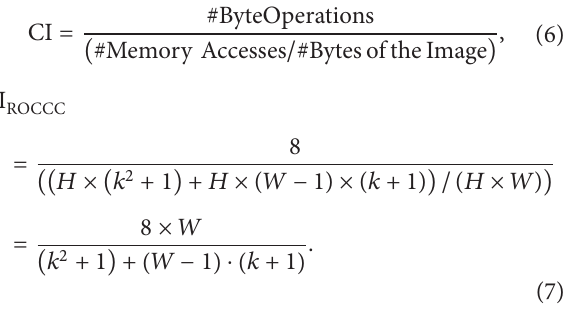
Figure 5: Example of how the partial loop unrolling reuse the fetched data. The kernel with 𝑘 = 3 depicted in (a) requires 9 input values. By unrolling two times, consecutive rows are processed in parallel in (b). In that case, besides the fact that each iteration demands 9 input values, 6 values are shared between both iterations, reducing the memory accesses. As the smart buffers are active, only 4 new inputs, the last column of each window, need to be